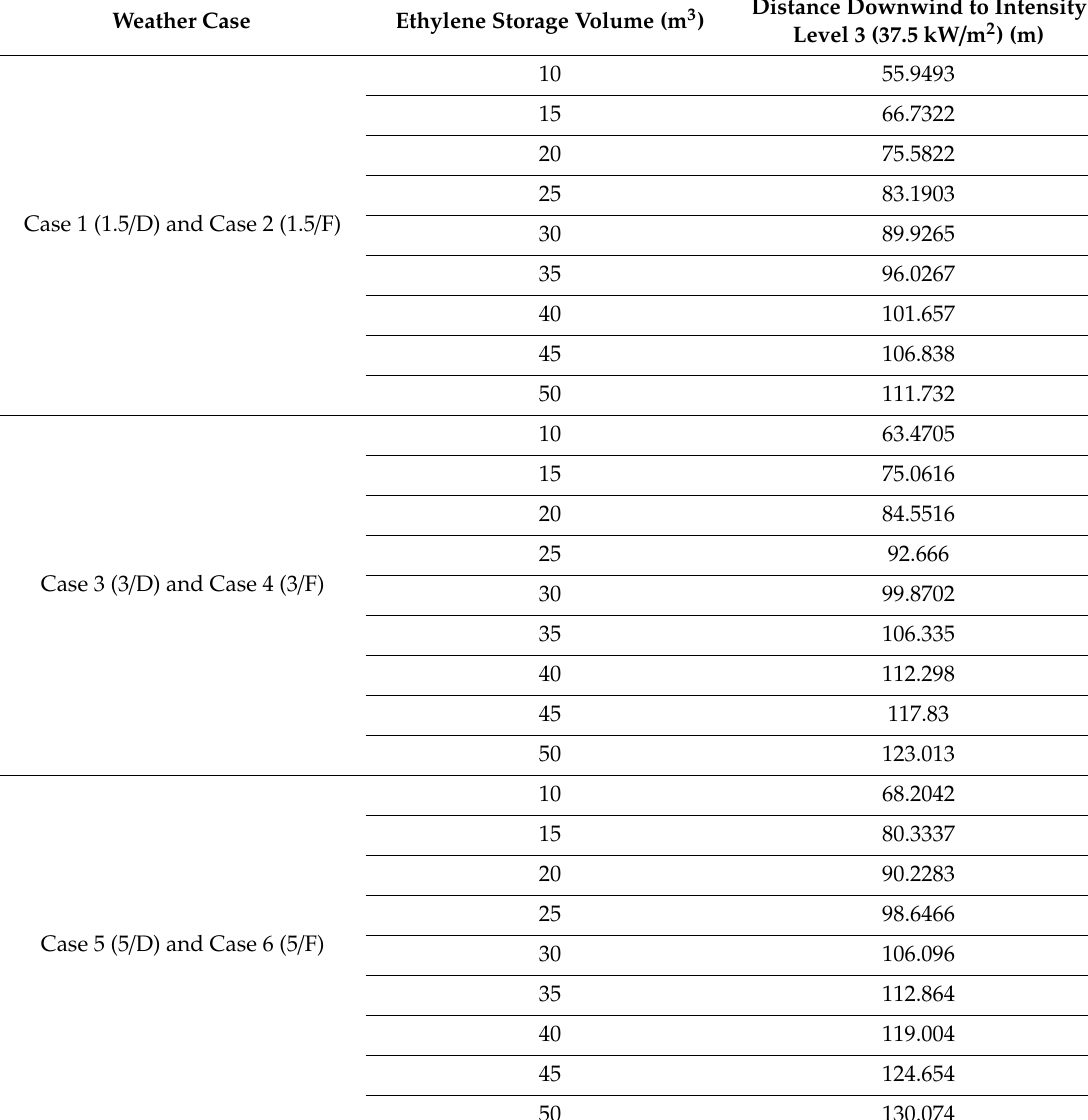
Table 4. Simulation results at ambient temperature (25 ◦ C).